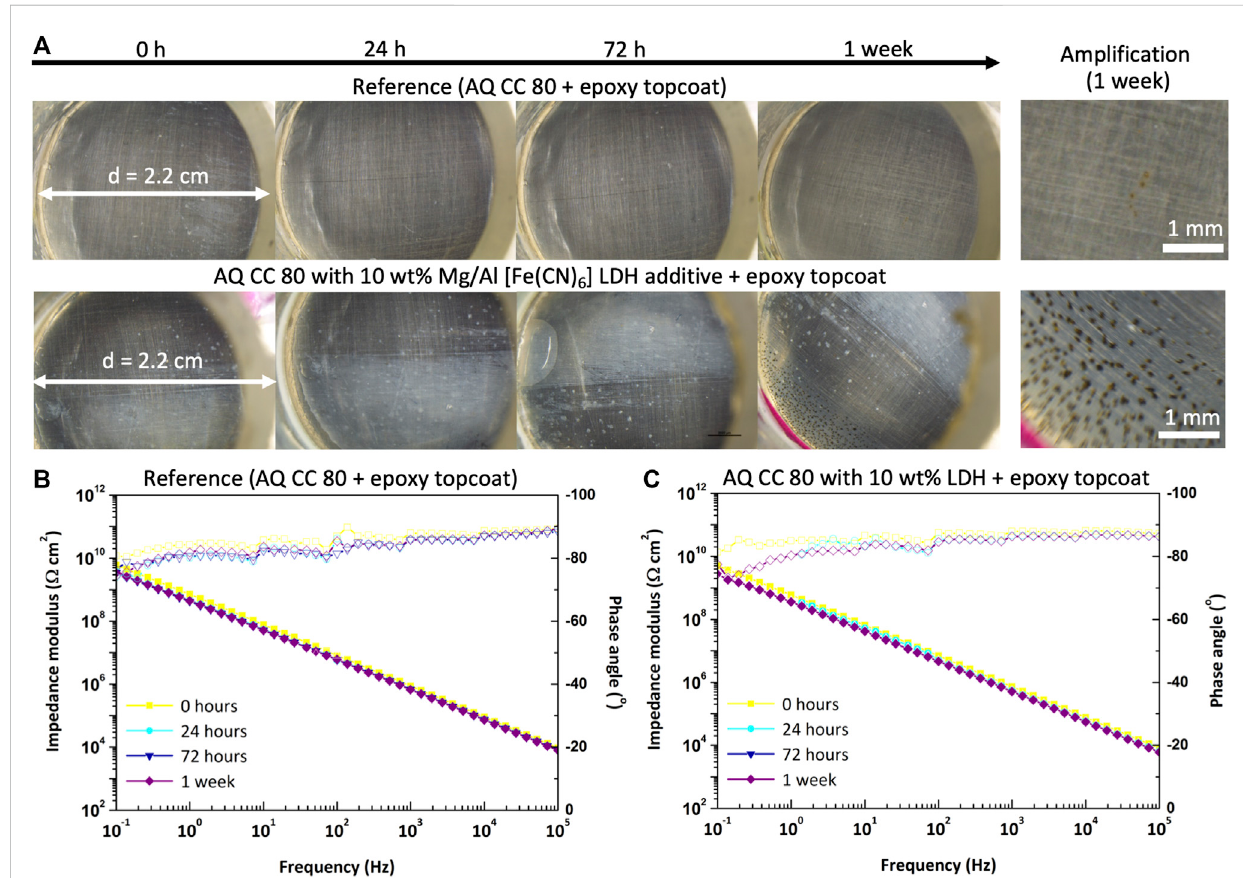
FIGURE 9 Visual analysis of the surface (A) and EIS spectra (B, C) of carbon steel plates coated with the multilayer system 1 with Mg-Al/[Fe(CN) 6 ] LDH nanoadditive (C) and corresponding reference multilayer system without the additive (B) immersed in 0.6 M NaCl solution during 1